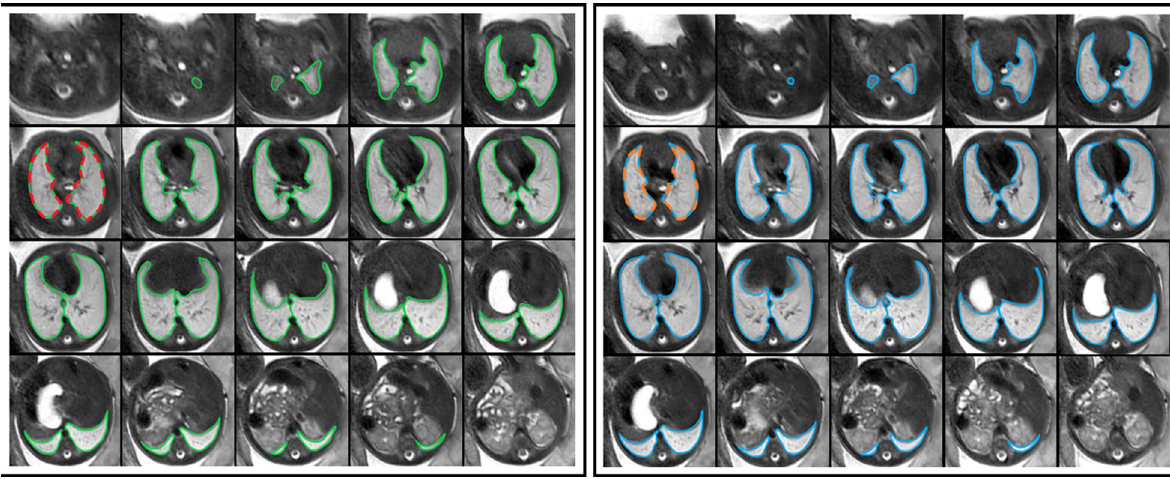
Fig. 1 Study design. Repeated acquisitions of T2-weighted axial MRI images of the lung in a fetus at gestational week 32. Three-dimensional (3D) regions of interest (ROIs) encompassing the whole lung were manually segmented in initial (green) and repeat (blue) acquisitions of 30 fetuses. Two-dimensional (2D) ROIs were defined as lung segmentations at the level of the carina in initial (red) and repeat (orange) acquisitions, respectively. Radiomics feature reproducibility was assessed between features extracted from 2 and 3D ROIs in the initial acquisition (red vs. green), 2D ROIs in repeated acquisitions (red vs. orange), and 3D ROIs in repeated acquisitions (green vs.